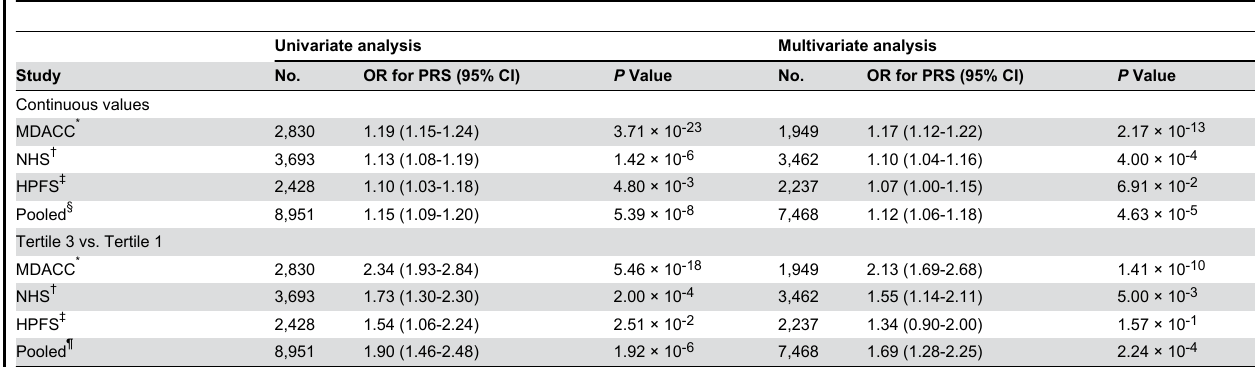
Table 3. Association between weighted polygenic risk score (PRS) and melanoma risk in 3 data